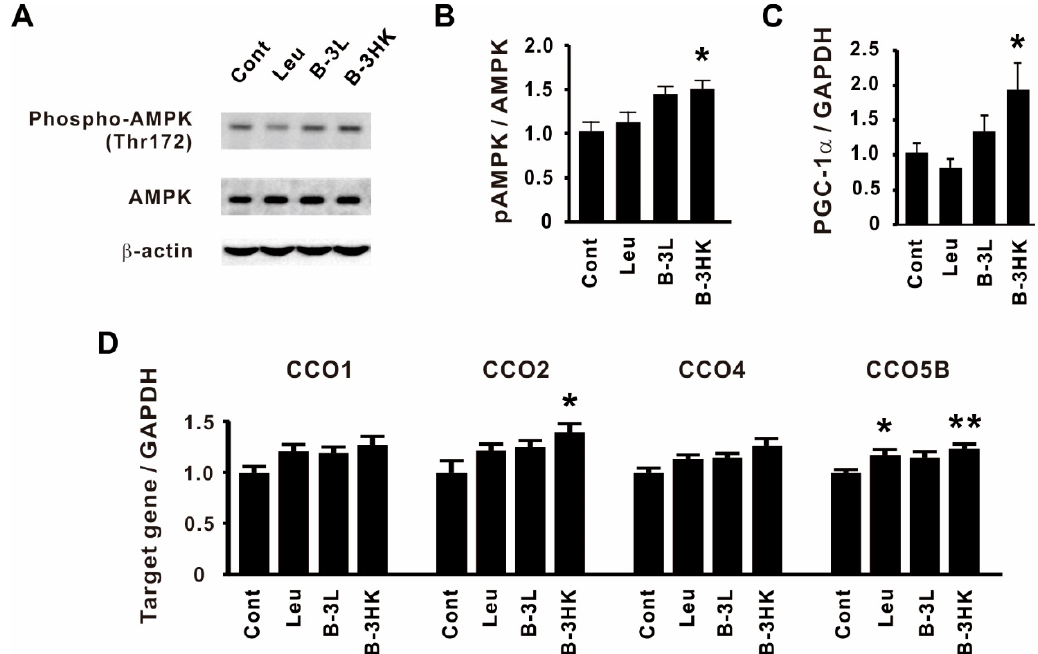
Figure 4. B-3 enhanced the AMPK-PGC-1 α -mitochondrial biogenesis signaling pathway in the soleus. ( A ) Representative bands and ( B ) the expression ratio of pAMPK to AMPK in the soleus are shown ( n = 6). ( C , D ) qPCR was used to evaluate the relative mRNA expressions of PGC-1 α , CCO1, CCO2, CCO4 and CCO5B in the soleus ( n = 12–13). Statistical differences were analyzed for significance using the Steel–Dwass test (* p < 0.05, ** p < 0.01, versus control). The data are expressed as means and SEs.